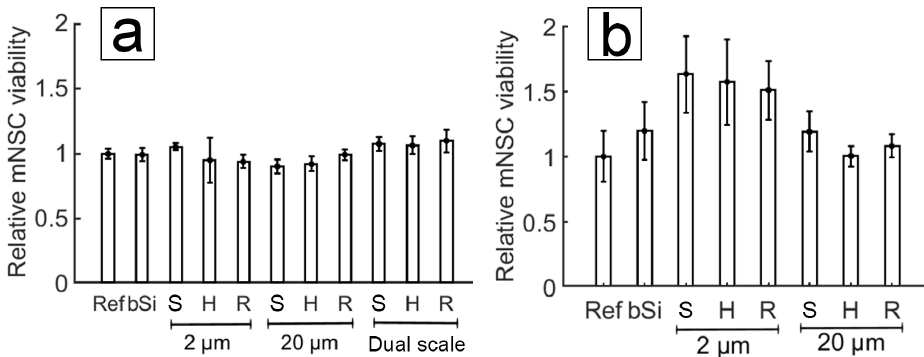
Figure 11. MTT assay readings for mNSC cultured on untreated carbon surfaces. Relative mNSC viability results on ( a ) PyC shows only minor differences between different structures, whereas ( b ) on ta-C the cell viability is increased with 2 µ m pillars. The sample codes denote ref for reference, bSi for nanorough black silicon surface, S for square-grid, H for hexa-grid, and R for